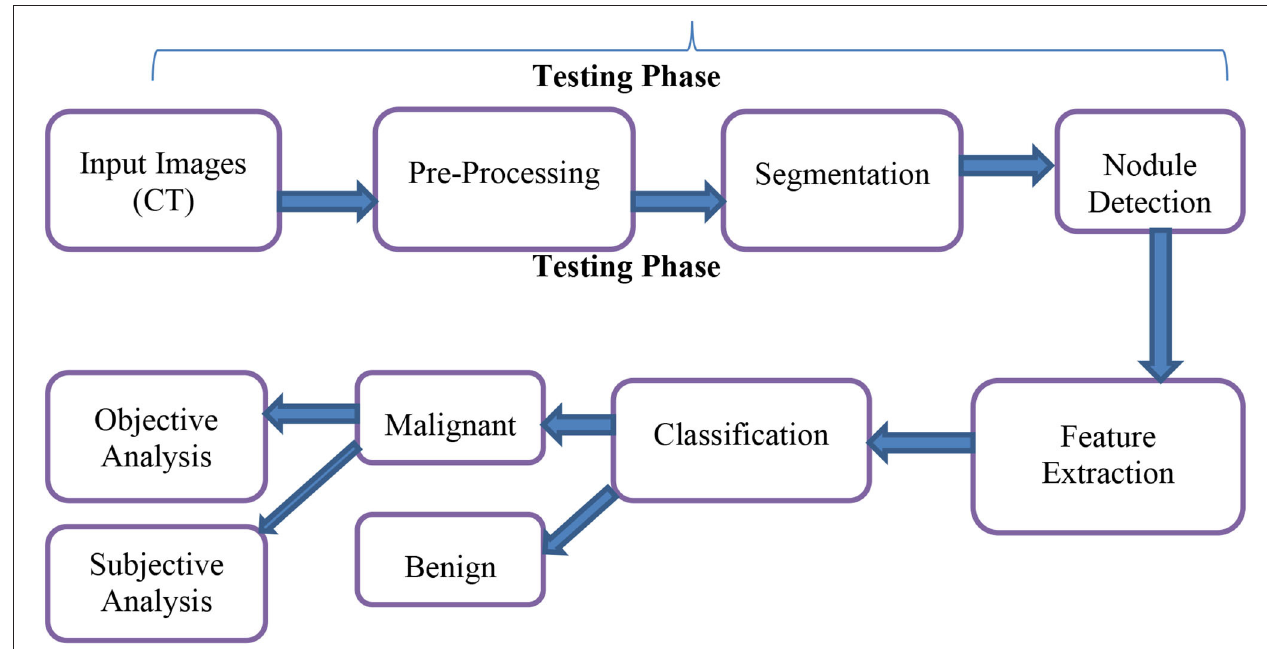
FIGURE 1 | Architecture of proposed